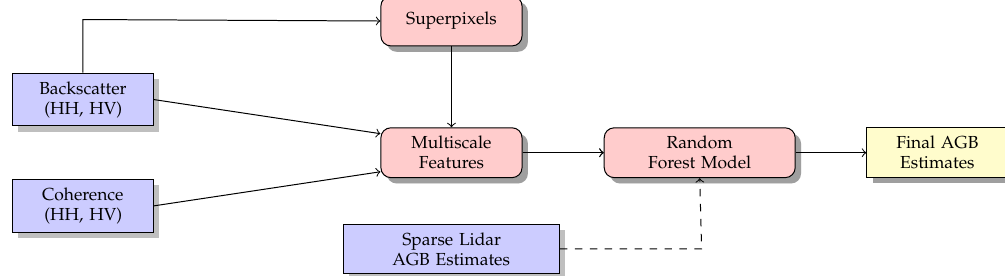
Figure 2. A summary of our methodology for AGB estimation. Blue indicates an input product, red indicates an intermediate product or model, and yellow indicates the final AGB estimates. The dashed line indicates that the sparse lidar data is only used for training the random forest